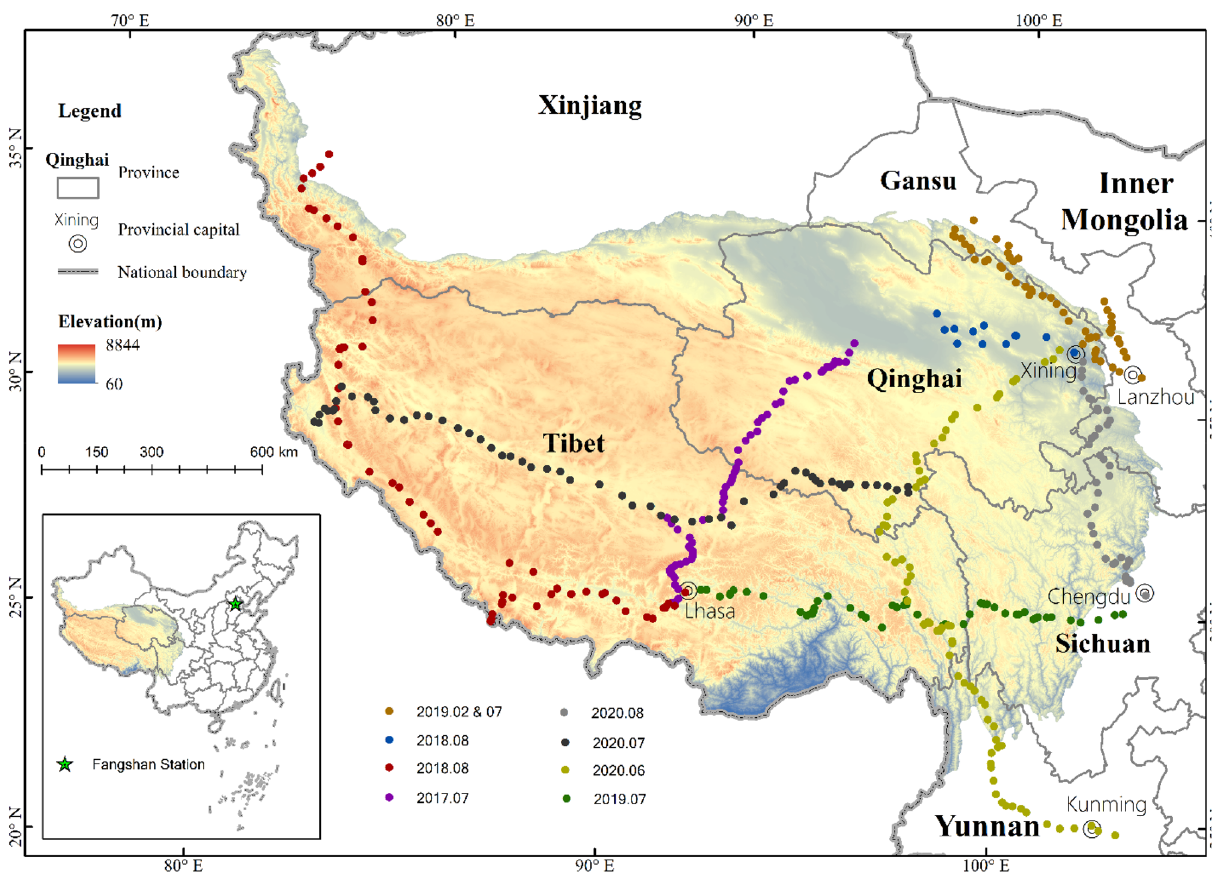
Figure 1. Location of the sampled sites (lower left: the QTP and Fangshan Station in China) (prepared by YC in ArcMap 10.3, https:// www. esri. com/ zh- cn/ arcgis/ produ cts/ arcgis- pro/ resou rces).